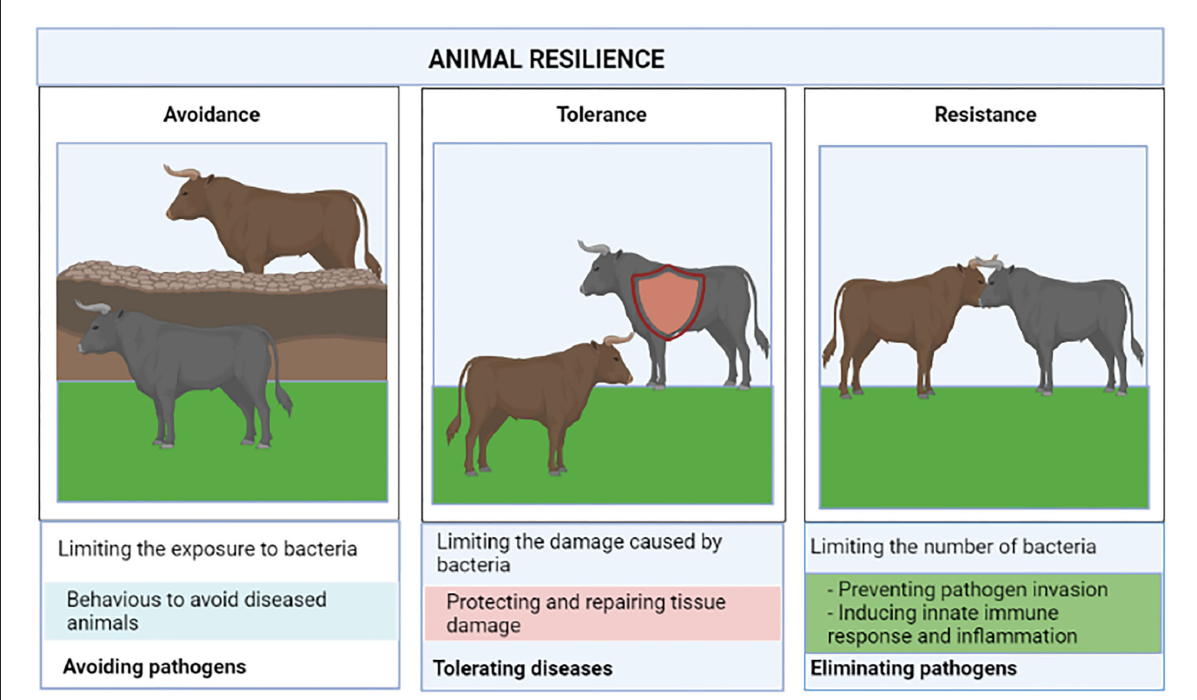
FIGURE1 Resilient animals defend themselves against pathogens using the complimentary strategies of avoidance, disease tolerance, and pathogen